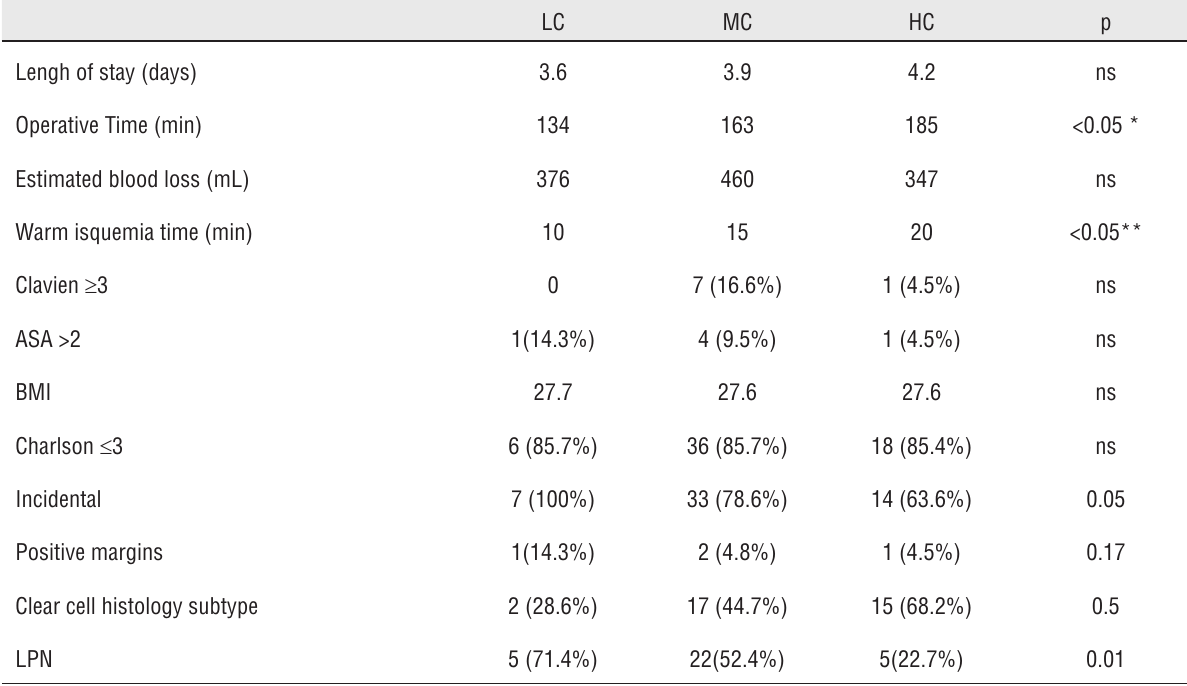
Table 2 - Distribution of variables according to renal